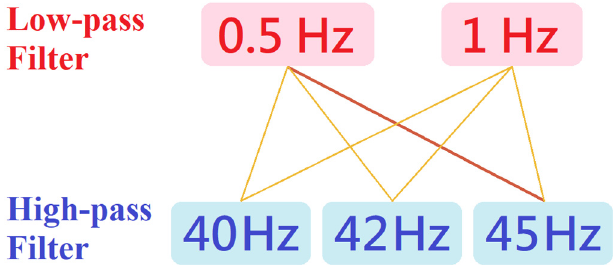
Figure 1. Combination of high and low frequency filters.